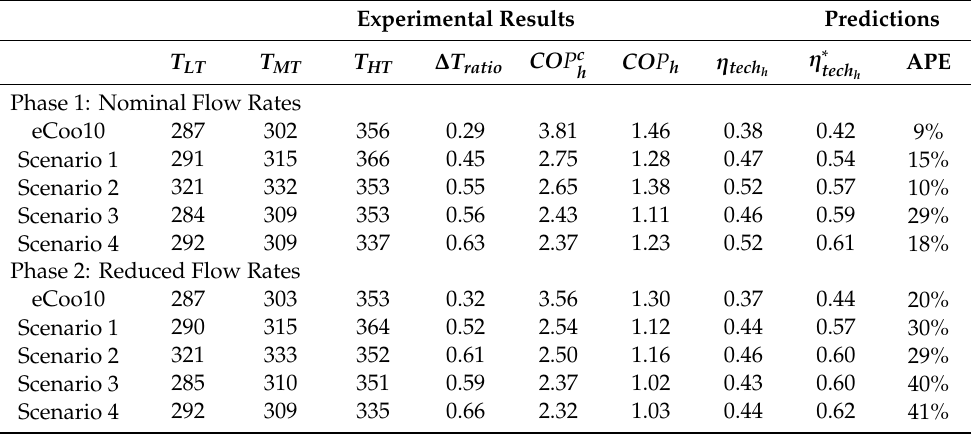
Table 6. Comparison of the experimental results with the model